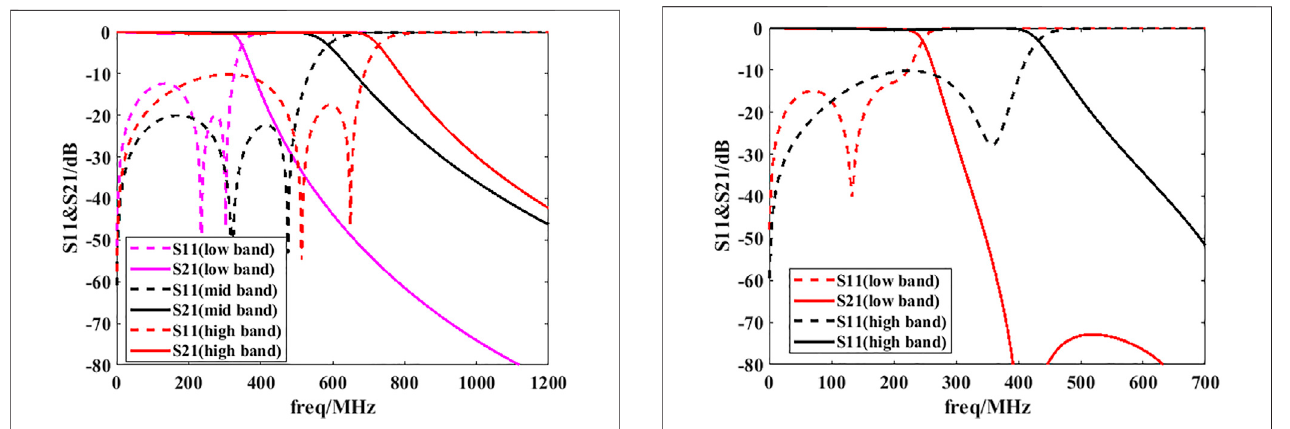
FIGURE 4 | The curve of transmission performance with Cc.